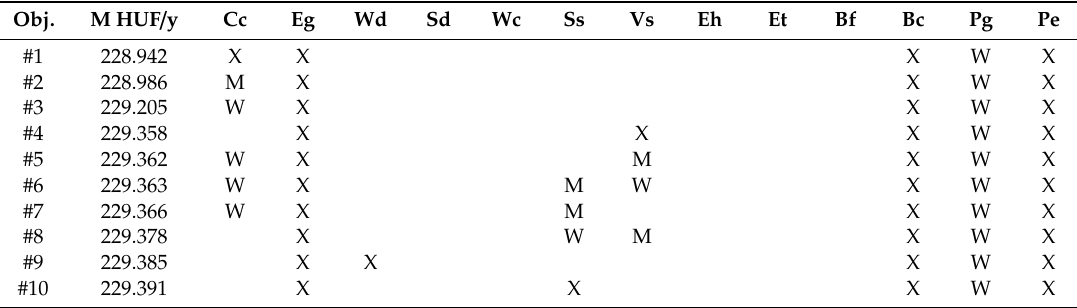
Table 9. The 10 best solution structures for the multi-periodic model. The objective values as well as the usage of technologies and biomass types in each period are depicted.*